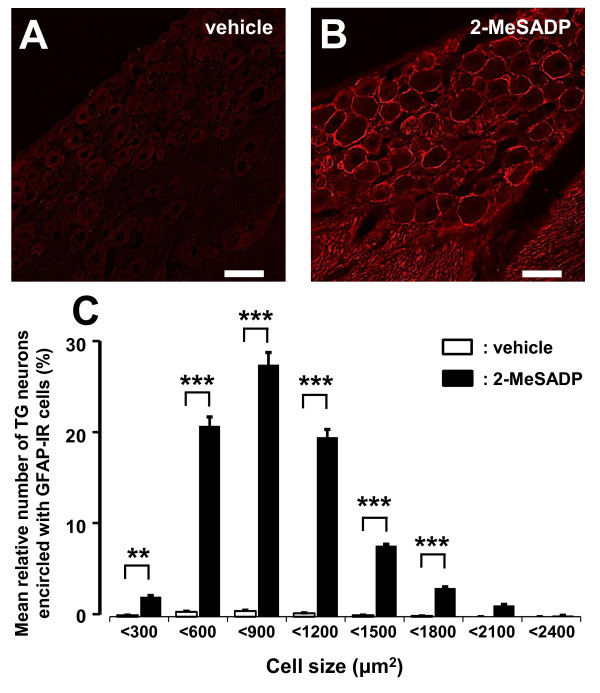
Effect of P2YR agonist on GFAP expression in naïve rats. Photomicrographs of GFAP-IR cells in V3 branch region following daily successive vehicle (A) or 2-MeSADP (B) administration (from day 0 to day 2) into TG on day 3 in naïve rats. C: The size-frequency histogram illustrating distribution of somata of TG neurons encircled with GFAP-IR cells in V3 region following successive daily 2-MeSADP (10.0 nmol/day) or vehicle administration (from day 0 to day 2) into TG on day 3 in naïve rats (C) **: p <0.01, ***: p < 0.001 (n = 5 in each group, Student's t-test). Scale bars = 50 μm.